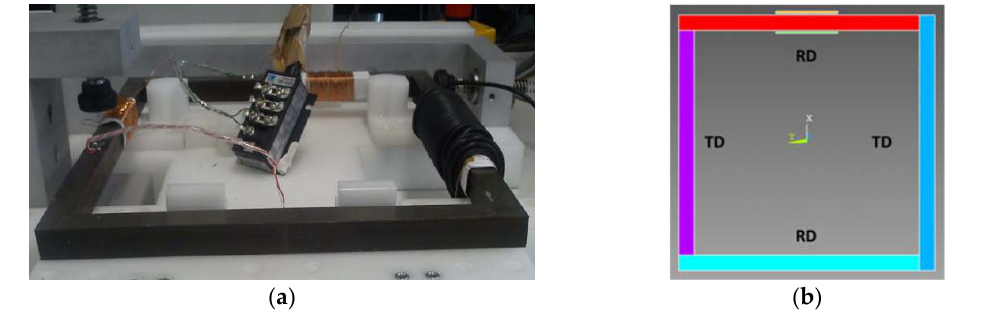
Figure 5. In house test bench: ( a ) real; ( b ) modeled.